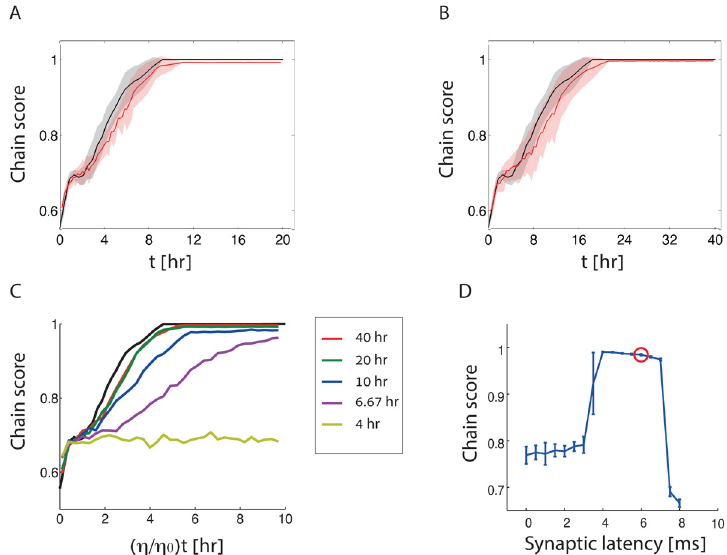
Fig 8. Formation of synfire chains under stochastic dynamics. A-B. Evolution in time of the chain score in the stochastic dynamics (red), compared with the prediction of the deterministic theory (black), shown for two different learning rates: η = 2 × 10 − 7 (A) and η = 1 × 10 − 7 (B) (see Methods for all other parameters). Solid traces: average over ten initial conditions. Limits of the shaded areas represent the standard deviation. Note the different time scales in A and B. C. Evolution in time of the chain score, shown for different learning rates ( η ) as a function of the time multiplied by η / η 0 where η 0 = 4 × 10 − 7 . Each trace represents an average over ten random intial conditions, with a specific learning rate: η = 10 − 7 (red), 2 × 10 − 7 (green), 4 × 10 − 7 (blue), 6 × 10 − 7 (purple), and 10 × 10 − 7 (yellow). The black trace represents the prediction of the deterministic theory. Note that the traces for the smallest learning rates (green and red traces, corresponding to panels A and B, respectively) nearly collapse on a single line, in close agreement with the prediction of the deterministic theory. The legend shows the actual time corresponding to the right end of the horizontal axis for each one of the plots. The synaptic latency d = 6 ms. D . Chain score evaluated in simulations of the stochastic dynamics, shown as a function of the synaptic latency (the red circle corresponds to the synaptic latency in panel C). The learning rate η = η 0 = 4 × 10 − 7 , matching the blue trace in panel C. Each data point represents an average over ten simulations with random initial conditions, and the error bars represent the standard deviation. The chain score is evaluated after 60 hours of simulated